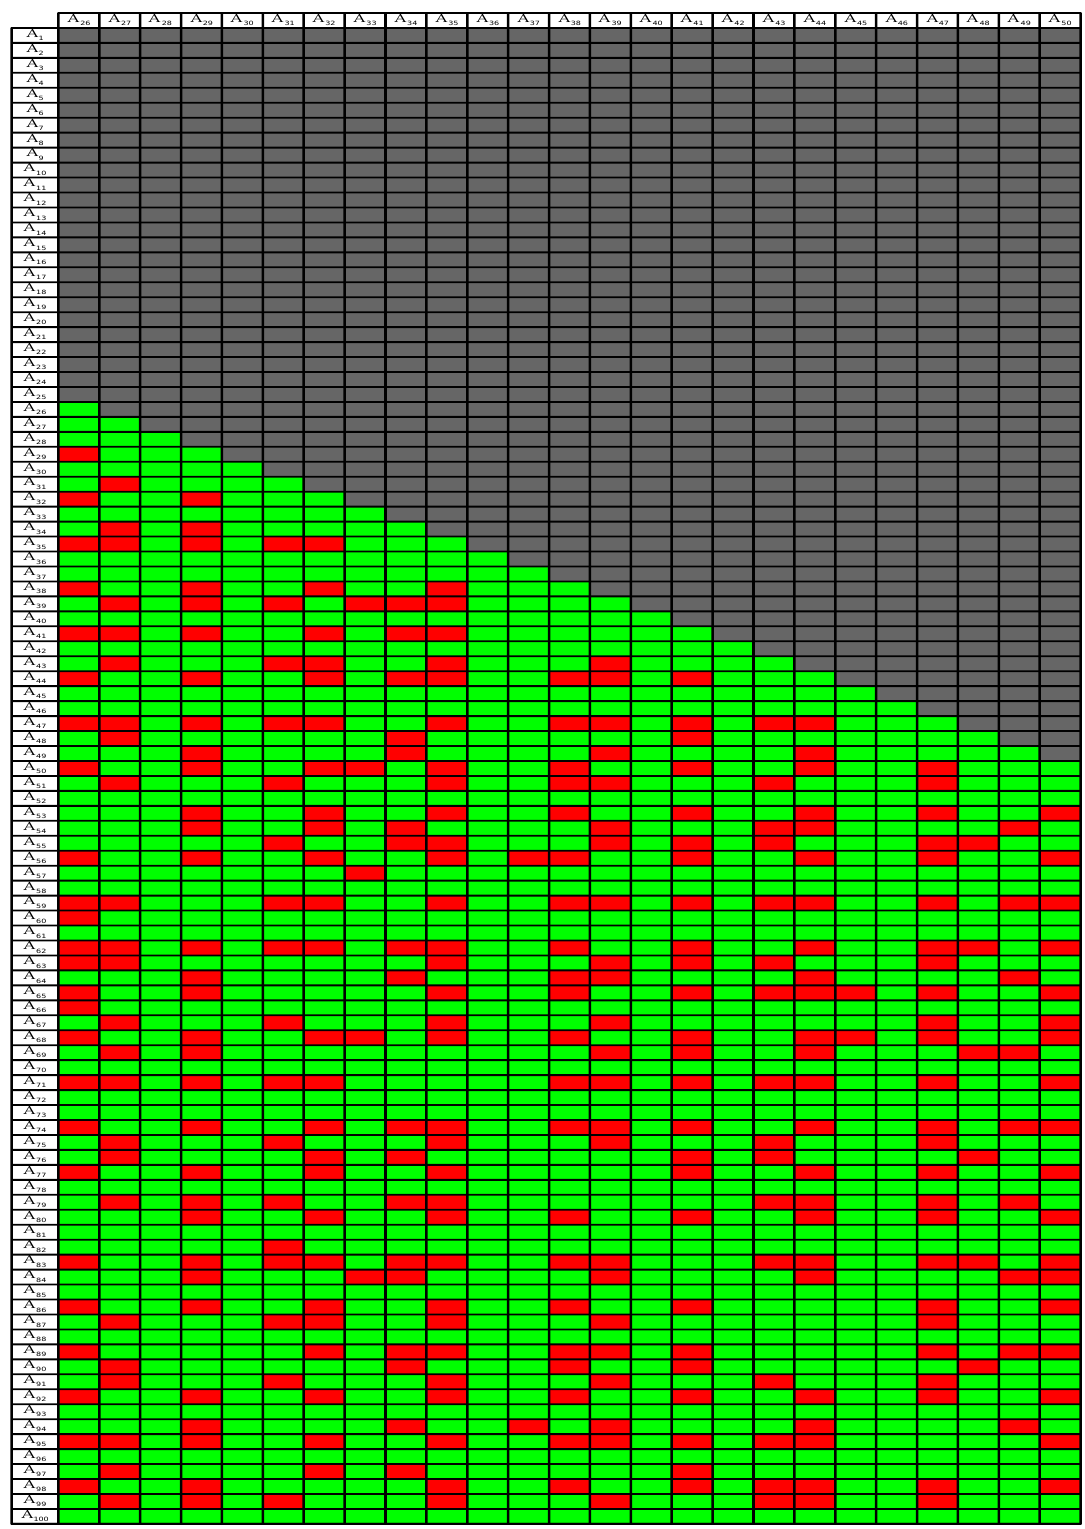
Table 3 . Analyzed theories for ( A n ; A m ) with n = 1 ; : : : 100 and m = 26 ; : : : 50.